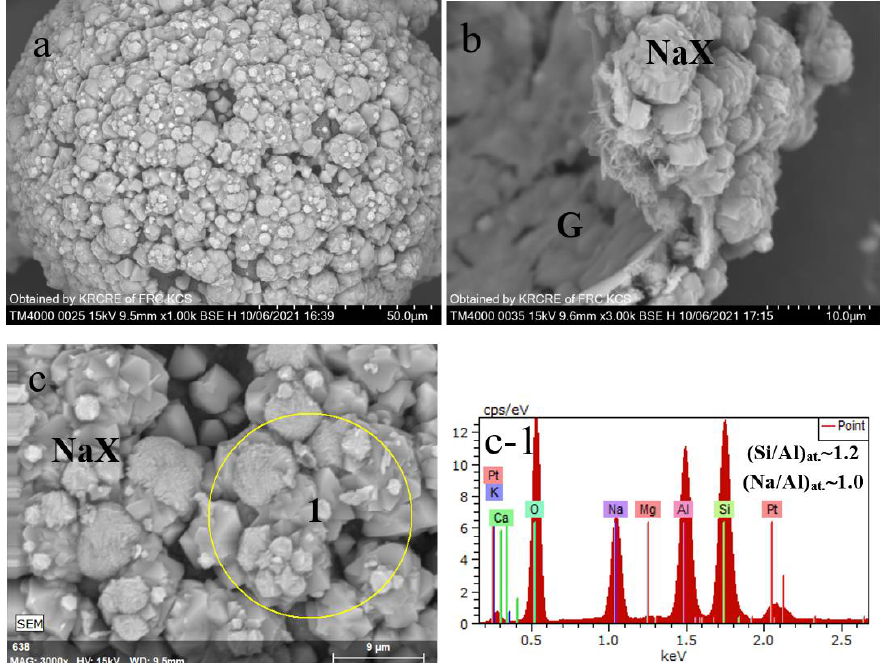
Figure 3. SEM images of product particles resulted from hydrothermal crystallization of cenosphere glass at 353 K ( a – c ); EDX spectra (c-1) for the local part of the zeolitized layer ( c ).